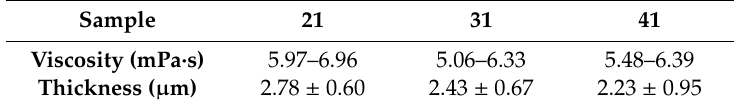
Figure 2. SEM / EDX analysis of a 21 sol–gel film applied on AA2024-T3 aluminum alloy: ( a ) SEM cross-section image (scale bar: 20 µ m); ( b ) EDX spectrum obtained on the AA2024-T3 aluminum substrate and ( c ) EDX spectrum obtained on a zone of the sol–gel films. Table 2. Viscosity and thickness values of the different control sol–gel films tested.